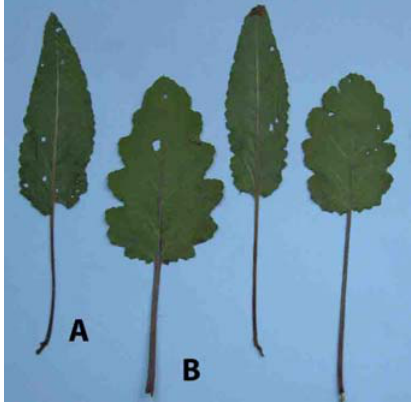
Figure 1a. Shapes of the rosette leaves in S. pratensis (A) and S. bertolonii (B).